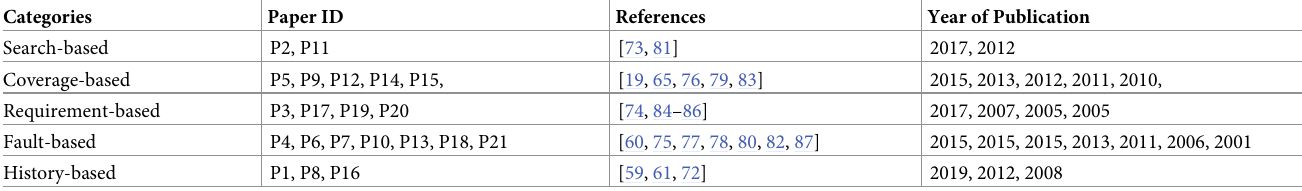
Table 9. Classification of value-based cost-cognizant TCP